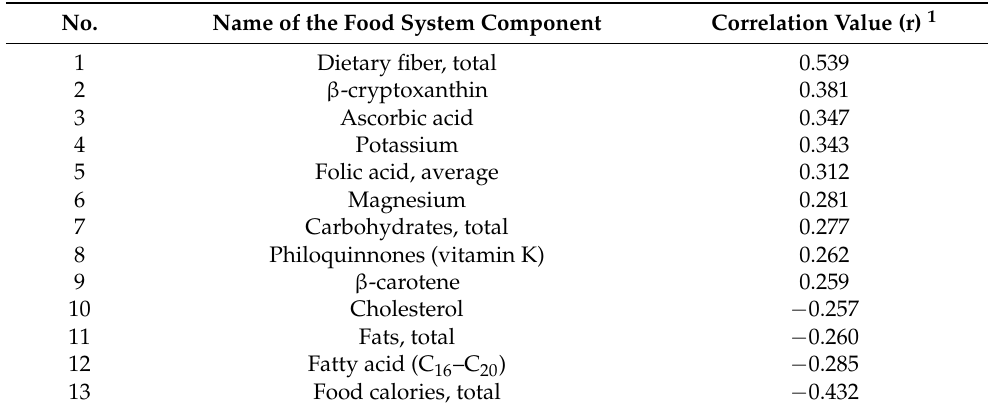
Table 1. Values of statistically significant correlations of the main components of food systems that affect the indicators of the ARP parameter of products predicted by ANN (for generalized